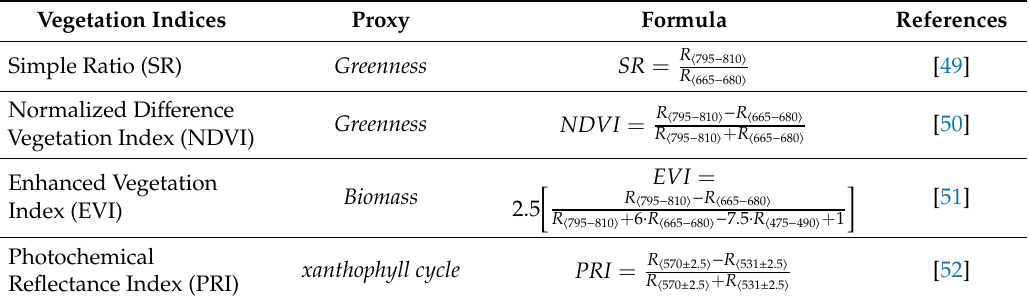
Table 1. Vegetation indices calculated from HyPlant DUAL data. R in formulas represents the reflectance. Numbers refer to wavelengths in